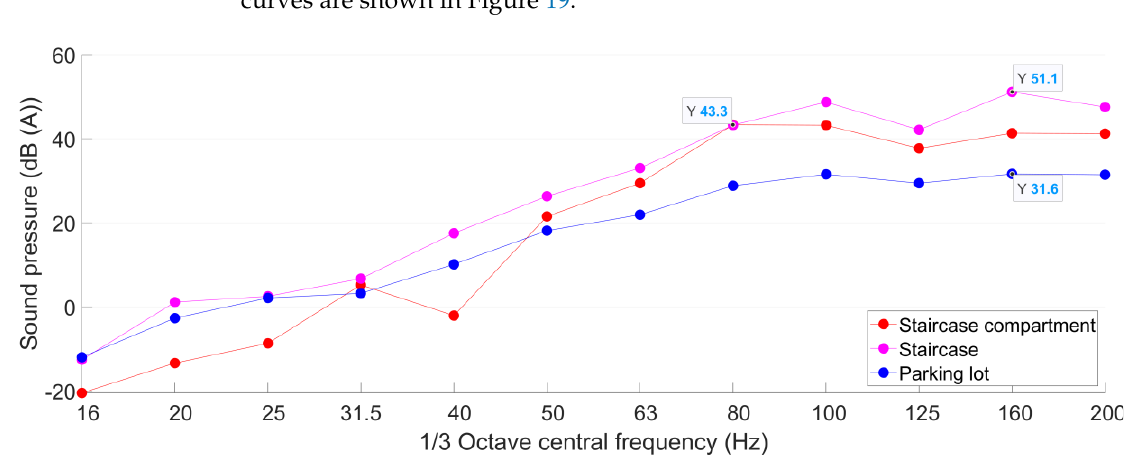
Figure 18. Development of ground vibration along the horizontal distance from the metro tunnel.